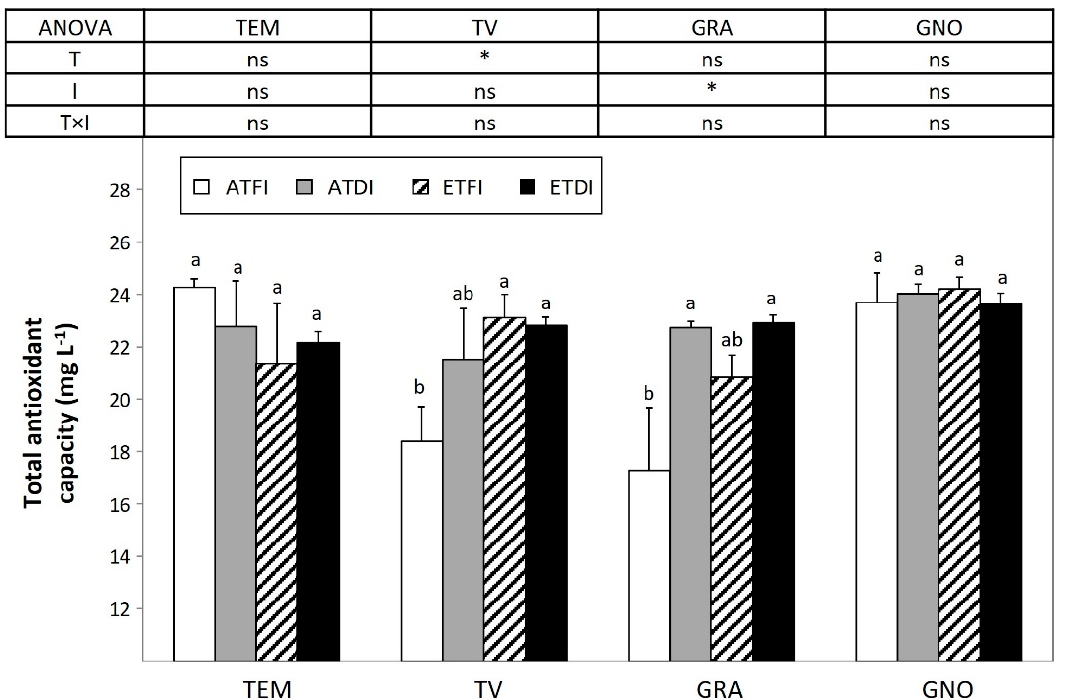
Figure 7. Antioxidant capacity of the must from fruit-bearing cuttings of ancient wine grape geno- types grown either at ambient (AT) or elevated temperature (ET) and subjected to different irrigation regimes (FI, full irrigation; DI, deficit irrigation). Values are means ± S.E. ( n = 5). Within each variety, bars topped by the same letter do not differ significantly ( p > 0.05) according to Duncan’s test. Two-way analyses of variance (ANOVA) assess the main effect of the temperature (T), irrigation (I), and their interaction (T × I). Significance of the analysis of variance (ANOVA): * p < 0.05; ns, not significant ( p ≥ 0.05). The variety labels can be found in Table 4.